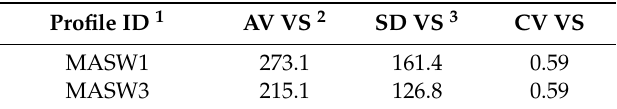
Table 5. VS models